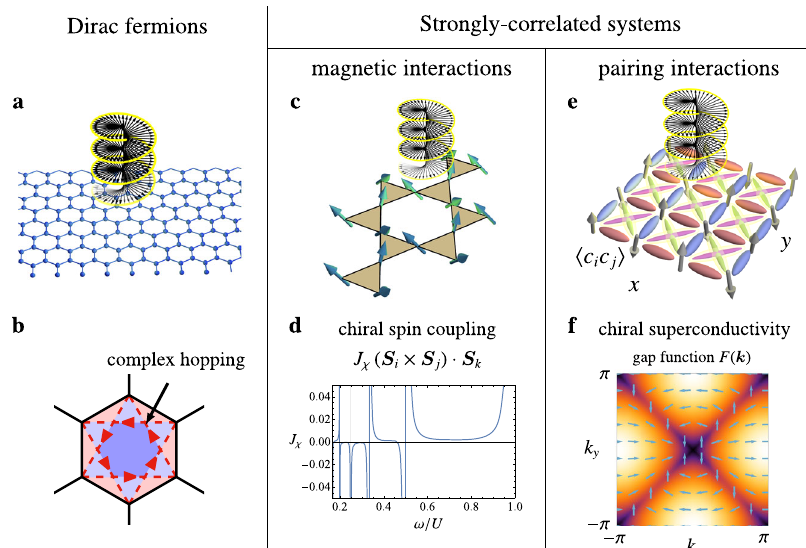
Fig. 1 Various Floquet-induced quantum states. For Dirac fermions as in graphene, a illumination of a circularly-polarised light (CPL) induces the Floquet topological insulator, which arises from photon-assisted complex hopping ( b ), where colour shadings represent the piece-wise magnetic fl uxes. c For magnetic phases in strongly-correlated systems, illumination of CPL induces a chiral spin coupling J χ ( S i × S j ) ⋅ S k with S i being the spin at site i , for which d illustrates a resonant behaviour in the coupling strength at ω / U = 1, 1/2, 1/3, ⋯ with ω being the driving frequency, and U the strength of the onsite repulsive interaction. e For superconductors (present work), illumination of CPL on a d x 2 (cid:3) y 2 -wave superconductor produces pairing amplitudes h ^ c i " ^ c j # i across nearest neighbours (red: positive; blue: negative) along with imaginary diagonal bonds (magenta and green), leading to an emergent complexi fi ed gap function F ( k ) in k space, and we have a photo-induced chiral d x 2 (cid:3) y 2 þ id xy superconductivity ( f ), where arrows schematically indicate the phase of the complex gap